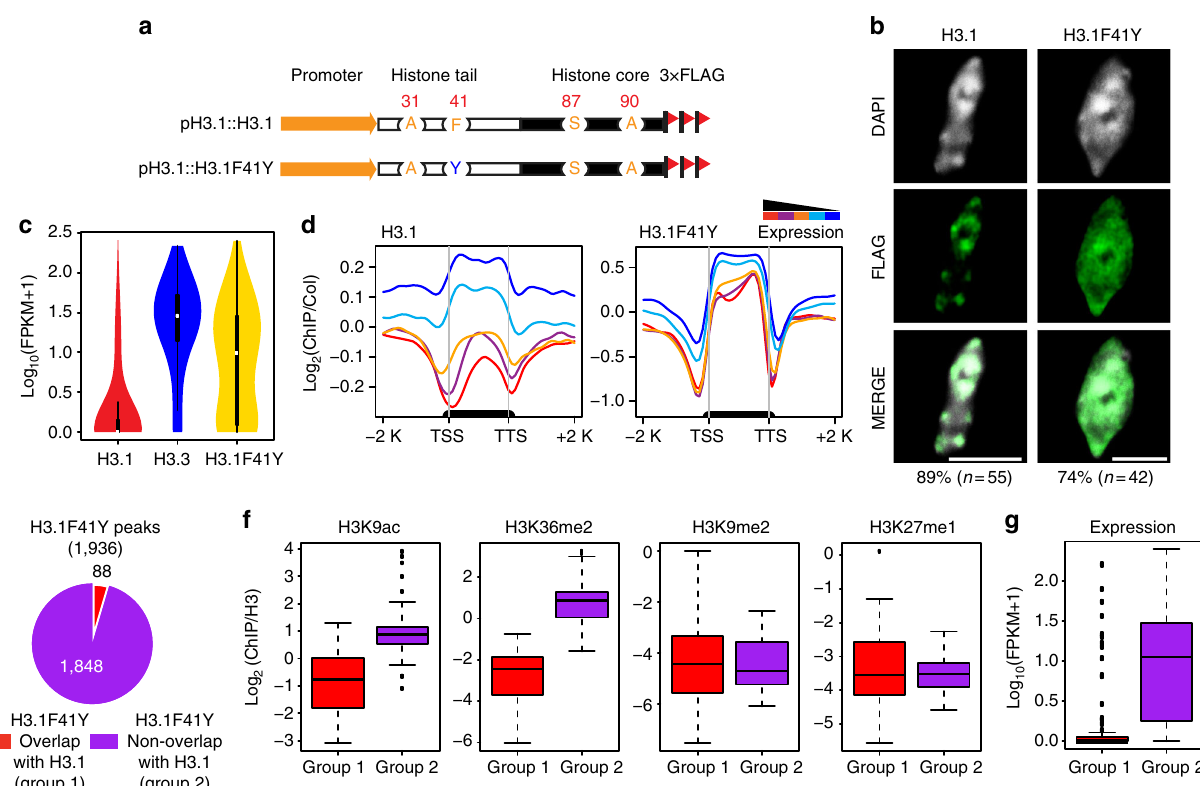
Fig. 3 Phe41 plays an important role in H3.1 distribution. a Schematic diagram of wild-type H3.1 and H3.1F41Y FLAG-tagged constructs. b Localization of wild-type H3.1 and H3.1F41Y protein in nuclei (bar = 5 μ m). The n represents the total number of examined nuclei. The percentage describes the ratio of the nuclei showing the H3 distribution pattern out of total examined nuclei. DAPI indicates the DAPI staining of the nucleus. c Violin plot of the expression levels of genes associated with H3.1, H3.3, and H3.1F41Y ChIP-seq peaks. The y -axis represents the log 10 value of FPKM +1. RNA-seq data were from 3- week-old seedlings. d Metagene plots of wild-type H3.1 and H3.1F41Y ChIP-seq reads over fi ve groups of genes divided based on their expression levels. The black bar in the x -axis represents genes. TSS transcription start sites; TTS transcription terminal sites; − 2 K and +2 K represent 2 kb upstream of TSS and 2 kb downstream of TTS, respectively. The y -axis represents the log 2 value of H3.1 and H3.1F41Y ChIP-seq reads normalized to those of Col-0. e Pie chart showing the H3.1F41Y ChIP-seq peaks that overlapped with H3.1 peaks (de fi ned as Group 1) or not overlapped with H3.1 peaks (H3.1F41Y unique peaks, de fi ned as Group 2). f Boxplots of histone modi fi cation levels over peak-associated genes from the two groups de fi ned in e . The y -axis represents the ChIP-seq reads normalized to those of H3. Histone modi fi cation ChIP-seq data were from 2-week-old aerial tissues. g Boxplot of expression levels of genes associated with the peaks from the two groups de fi ned in e . FPKM, fragments per kilobase of transcript per million mapped